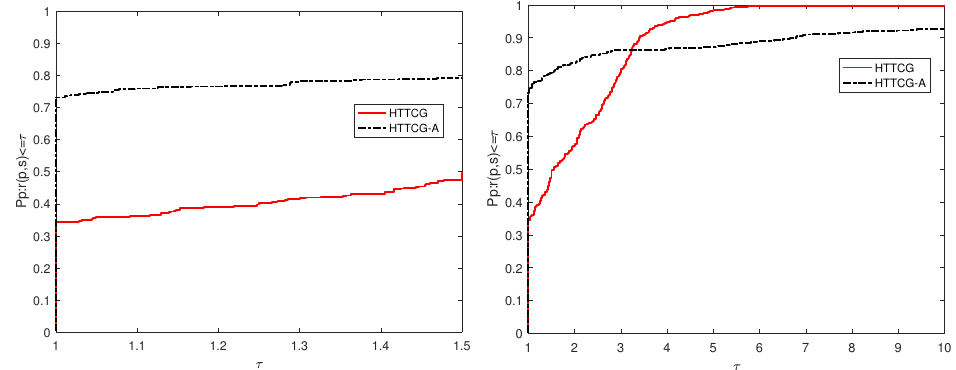
Figure 5. Performance profiles of Algorithm 2 and the acceleration form in NFG case.